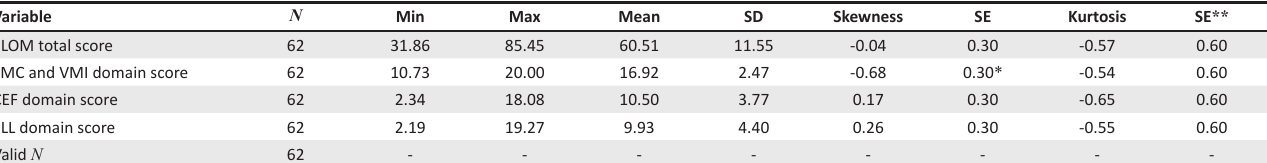
TABLE 5: Early Learning Outcomes Measure descriptive statistics. Variable N